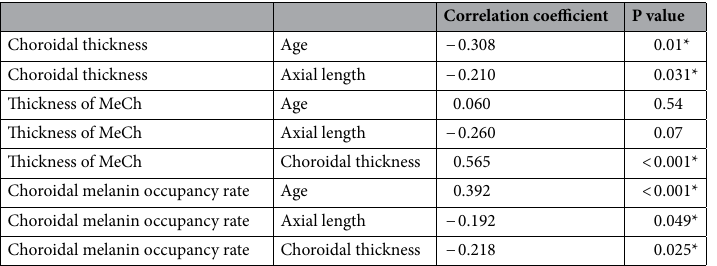
Table 1. Summary of simple linear regression analysis of choroidal thickness, thickness of MeCh, and choroidal melanin occupancy rate. Thickness of MeCh: thickness of melanin-containing tissue in the choroid. *Statistically significant